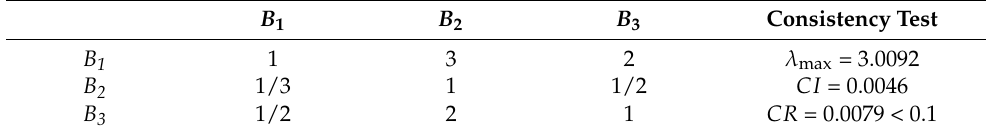
Table 8. Evaluation index weights based on AHP.